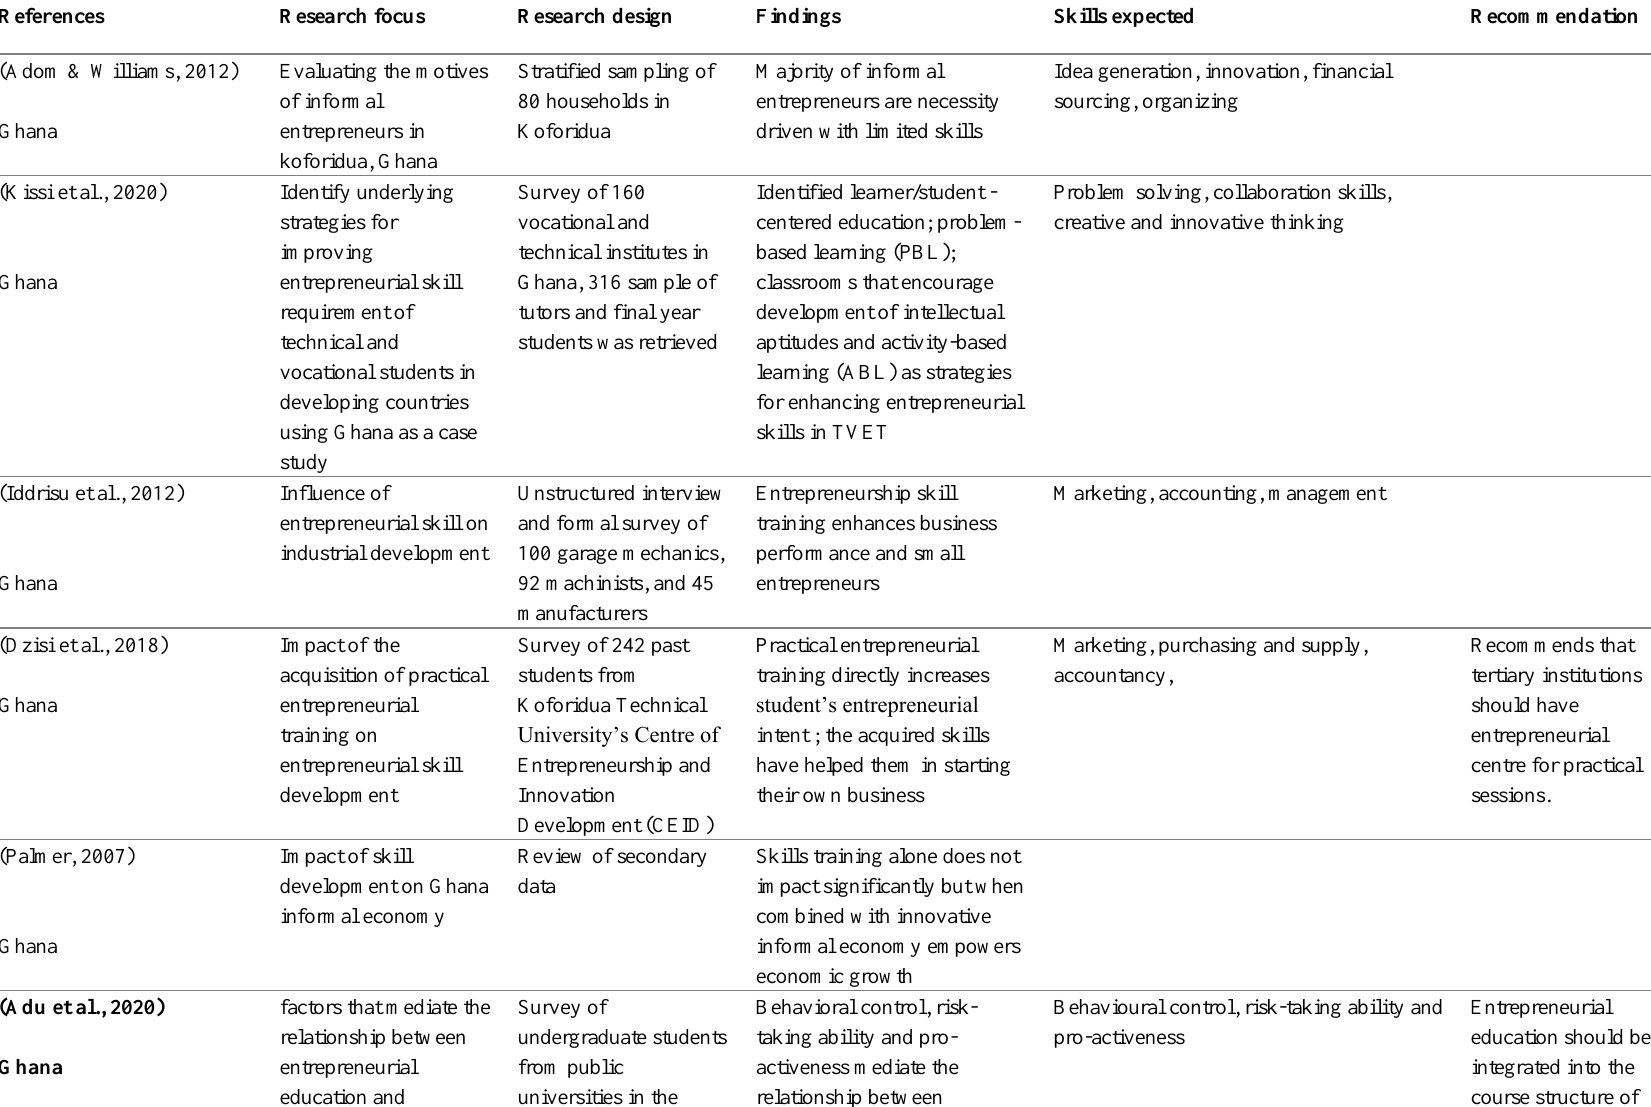
Table 2: Overview of Impact of Skill Acquisition on Entrepreneurship Development Across Eight (8) Selected Ghanaian Journal